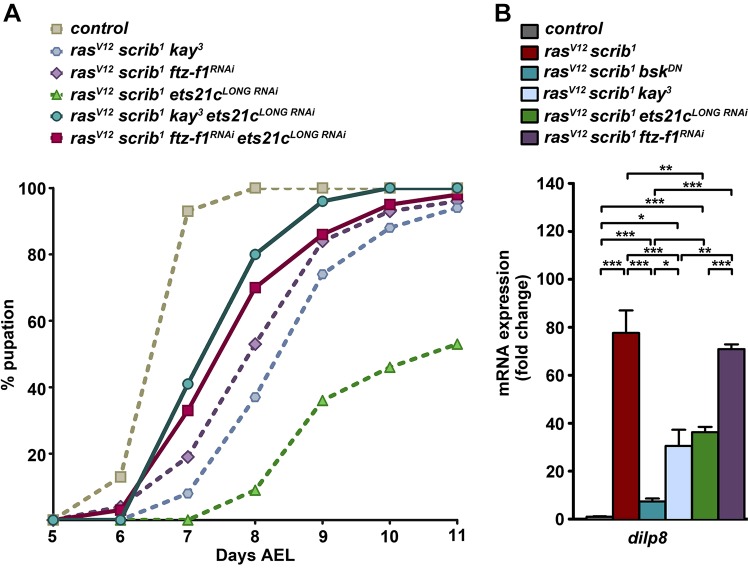
Loss of fos or knockdown of ets21c partly suppresses dilp8 expression, and simultaneous TF inhibition further improves pupation timing. (A) Suppression of ets21cLONG and fos in rasV12scrib1 tumors improved timing and progression of pupation by 1 day compared with the single knockdowns (P<0.0001; dashed lines repeated from Fig. 3). A mild improvement is also observed upon combined knockdown of ets21cLONG and ftz-f1 (P<0.005). Some rasV12scrib1ftz-f1RNAiets21cLONG RNAi animals eclosed as adults, whereas rasV12scrib1kay3ets21cLONG RNAi individuals all died as pupae. The graph shows the cumulative percentage of pupae forming over time. (B) Elevated expression of dilp8 mRNA in rasV12scrib1 mosaic EAD was reduced upon JNK inhibition, loss of fos or ets21cLONG knockdown, but not in rasV12scrib1ftz-f1RNAi tumors. Data are mean values±s.e.m.; n=3-5; ***P<0.001; **P<0.005; *P<0.01.